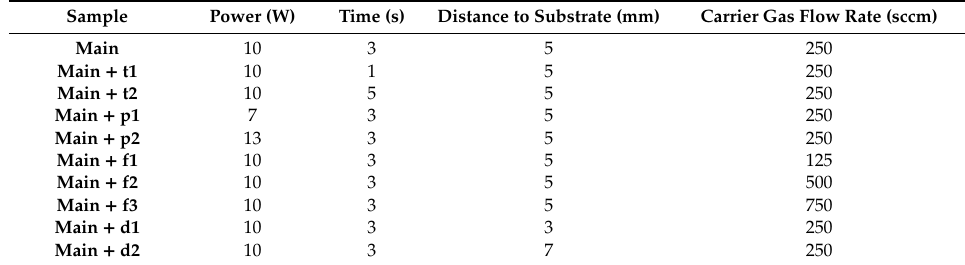
Figure 1. Scheme of the experimental plasma set-up: 1—mass flow controllers; 2—quartz capillary; 3—surfatron resonator; 4—microwave (MW) antenna; 5—MW coaxial cable; 6—Macor plate with precursor injection; 7—plasma torch; 8—optical fiber; 9—bubbler system in water–ice bath; 10—substrate. Table 1. Summary of the selected experimental conditions. Legend: sccm, standard cubic centimeters per minute.